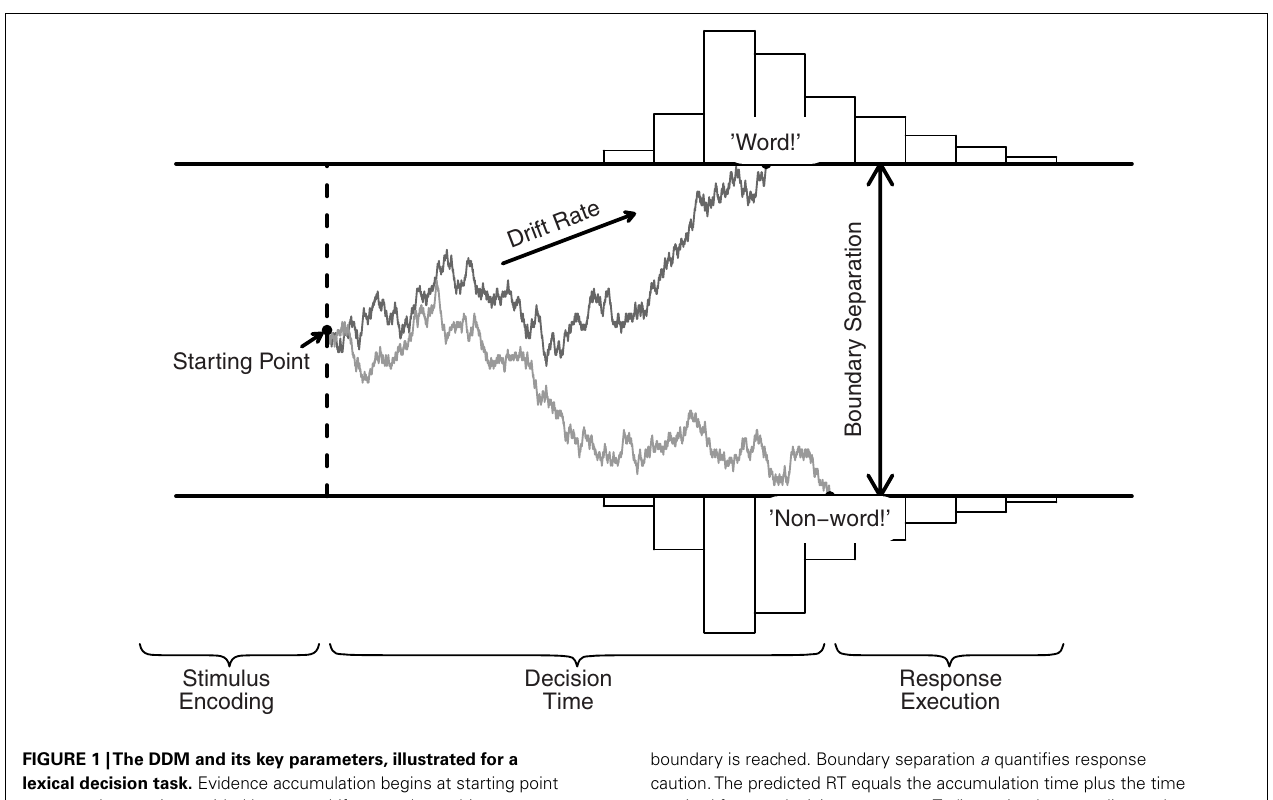
FIGURE 1 |The DDM and its key parameters, illustrated for a lexical decision task. Evidence accumulation begins at starting point z , proceeds over time guided by mean drift rate v , but subject to random noise, and stops when either the upper or the lower